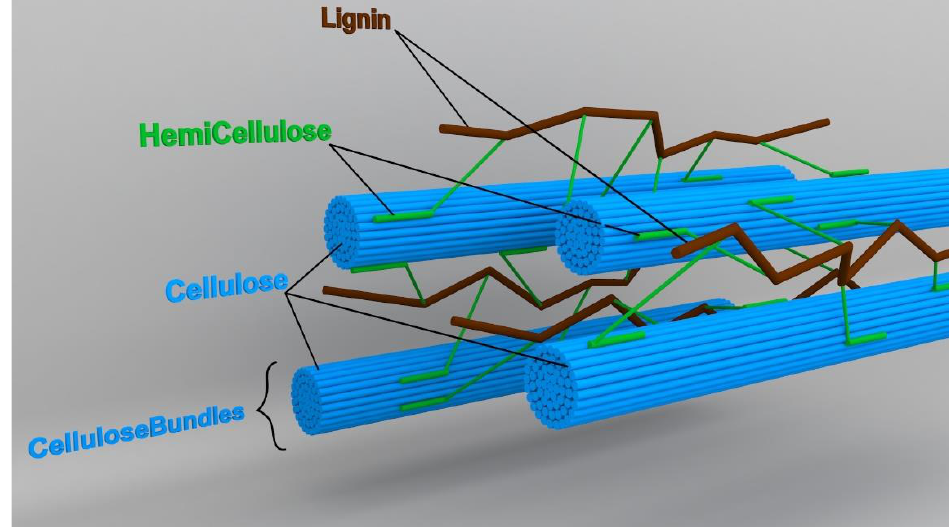
Figure 1. Structure of Lignocellulosic Materials.